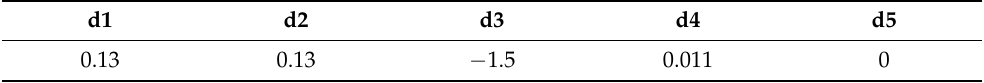
Table 3. The failure parameters of the Johnson–Cook fracture criterion for Al matrix